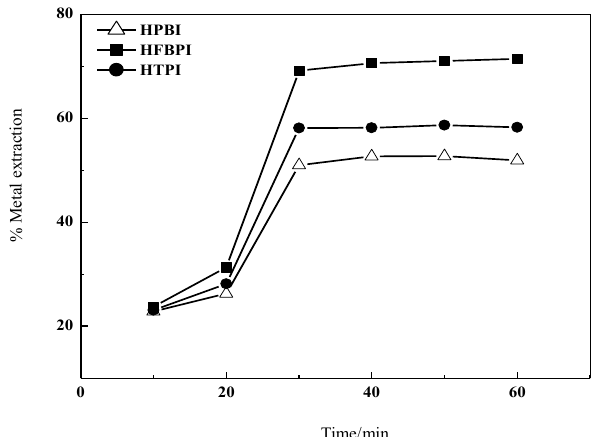
Figure 2. Kinetic equilibrium of Pd(II) with 4-aroyl-3-phenyl-5-isoxazolones(HA). [HA] =